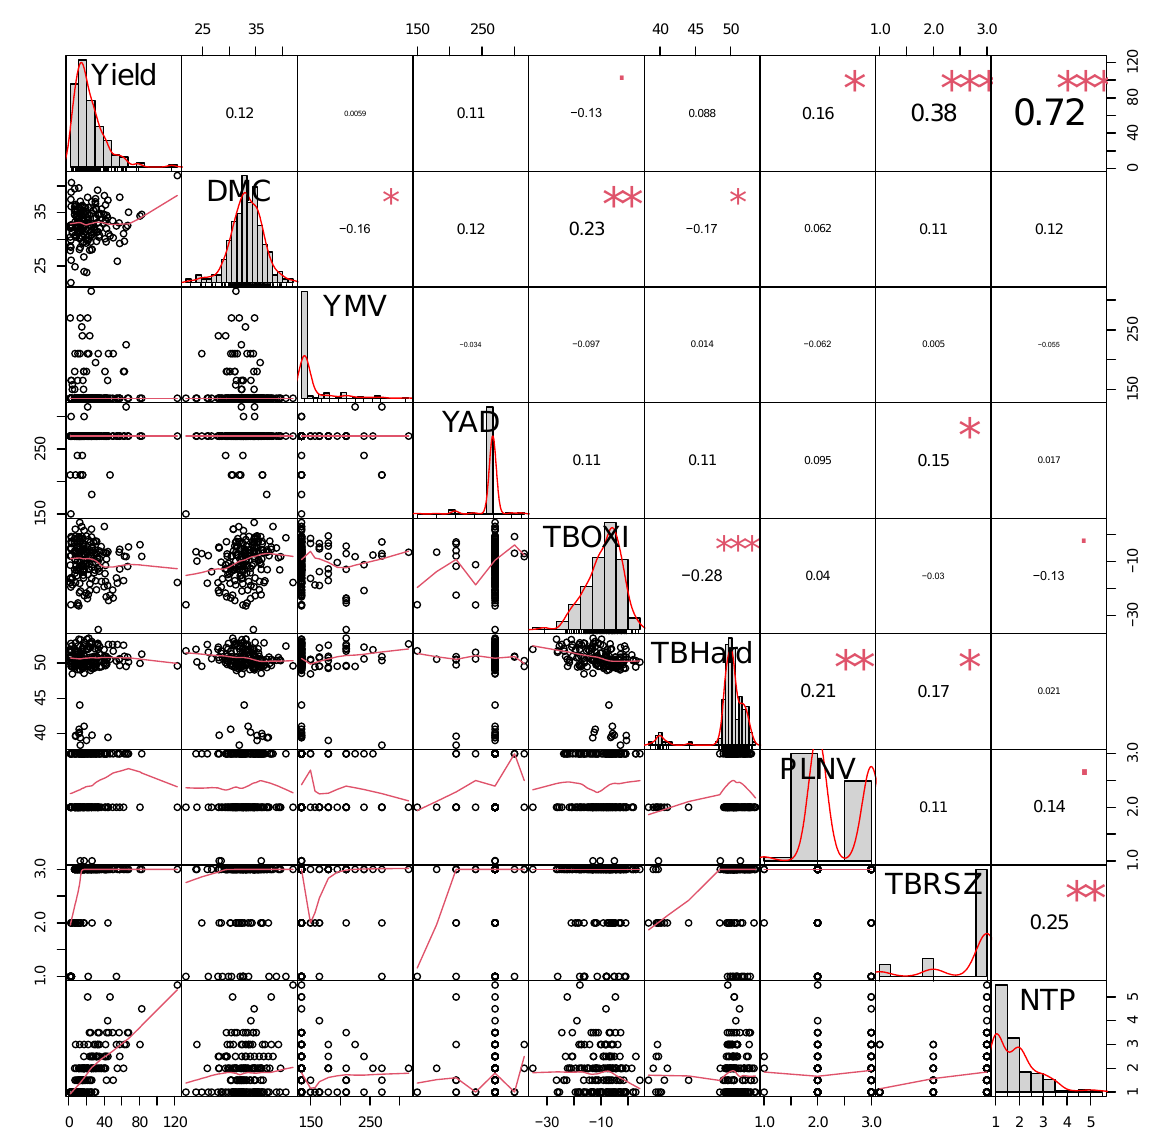
Figure 2. Correlation coefficients among agronomic and tuber quality traits. DMC = Dry matter content, YMV = Yam mosaic virus, YAD = Yam anthracnose disease, TBOXI = Tuber flesh oxidation, TBHard = Tuber flesh hardness, PLNV = Plant vigour, TBRSZ= Tuber size, NTP = Number of tubers per plot. Significance level: “ p < 0.1“ = . “ p < 0.05” = *; “ p < 0.01” = **; “ p < 0.001” = ***.